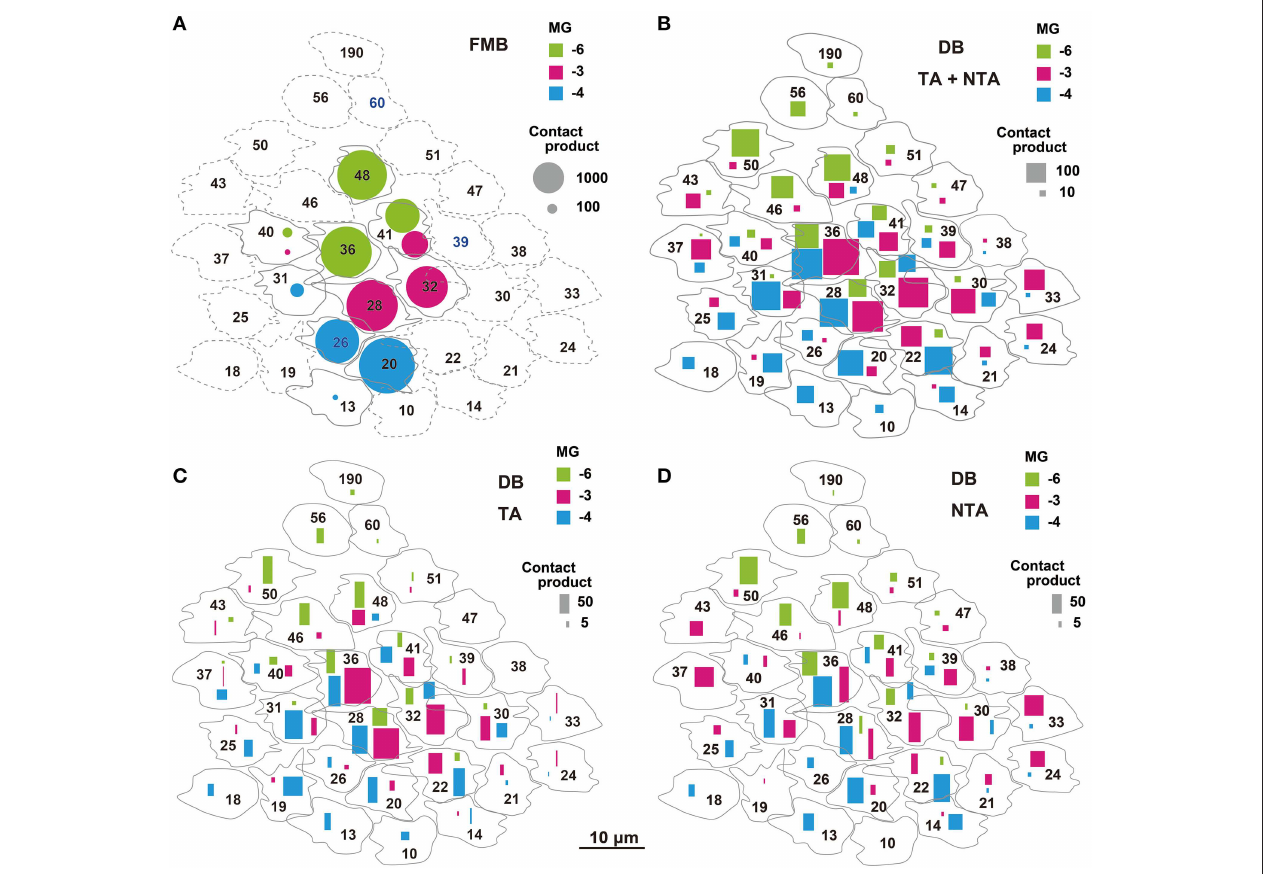
FIGURE 12 | Narrow and wide convergent cone fields of OFF midget ganglion cells estimated by the products of cone-bipolar and bipolar-ganglion contact numbers. The product value is proportionally expressed as the area of each mark. (A) Narrow cone fields converging onto three adjacent OFF midget ganglion cells (MG-3 in red, MG-4 in blue, and MG-6 in green), each formed by the connectivity of two or three FMB cells. (B) Wide cone fields converging onto cells MG-3, MG-4, and MG-6, each formed by the connectivity of both TA and NTA contacts of all DB types. (C,D) Contributions of TA (C) and NTA (D) basal contacts from all types of DB cells to the wide cone field converging onto cells MG-3, MG-4, and